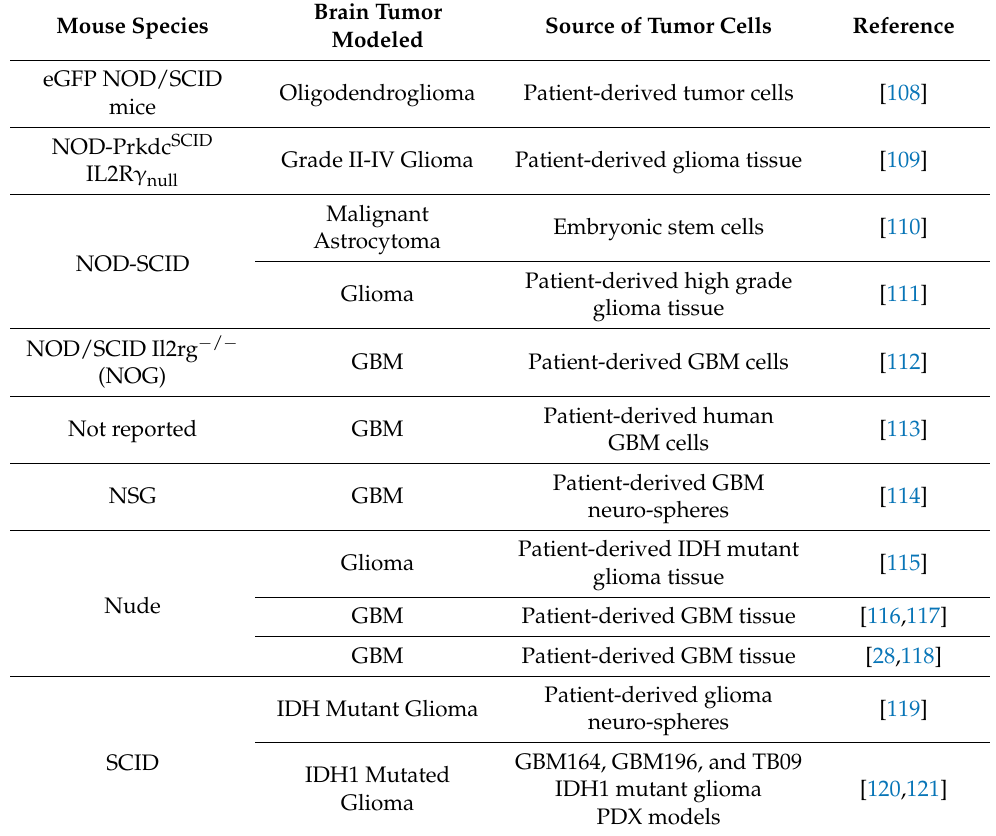
Table 3. Glioma patient-derived xenograft (PDX) murine